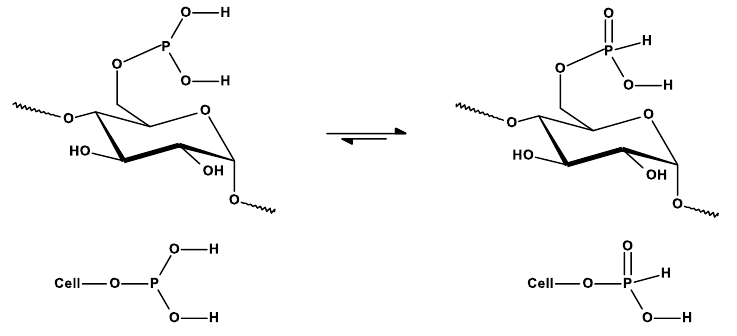
Figure 8. Equilibrium and structures of cellulose- O 6 -phosphate (III) (Cell- O 6 -P(OH) 2 Cell- O -P(O)(OH)-H).